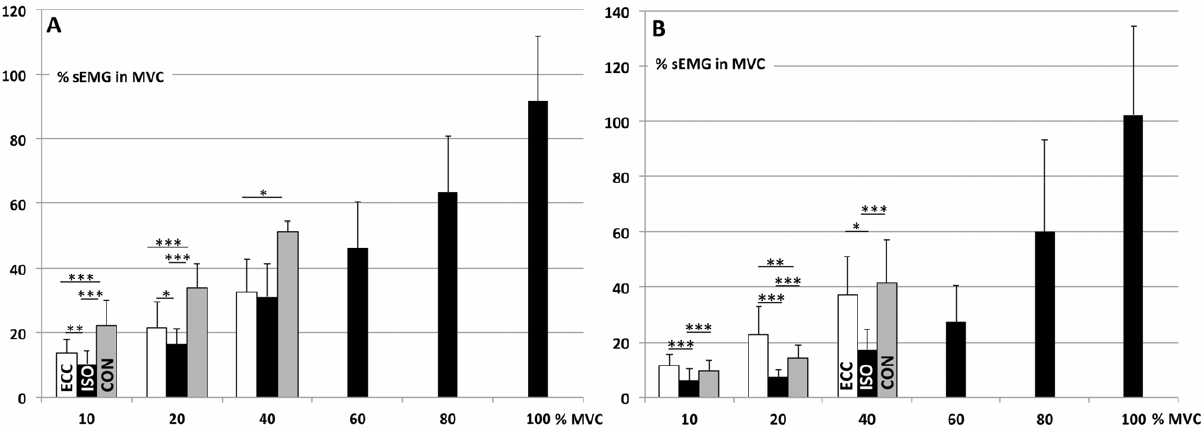
Figure 4. Relative muscle activity in different trials. sEMG levels of soleus (A) and gastrocnemius medialis (B) at different force levels in eccentric (ECC), isometric (ISO) and concentric (CON) contractions. sEMG is expressed relative to maximal isometric contraction (MVC). Significant differences between conditions and force-levels: * =p , .05, ** =p , .01, *** =p , .001.